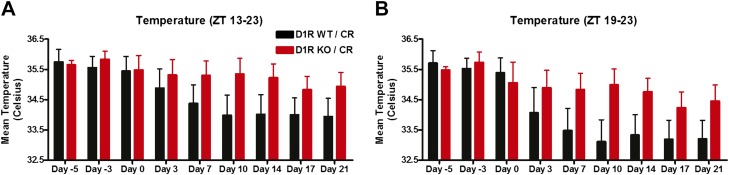
Entrainment of behavior and neuronal activation from D1 agonist injection.Body temperature measurements during lights-off (A) for the entire dark cycle and (B) for the last 4 hr of the dark cycle.